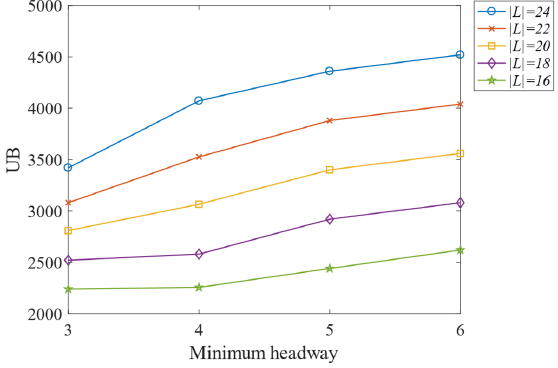
Figure 13. The variation tendency of UB with the increase in the minimum headway.